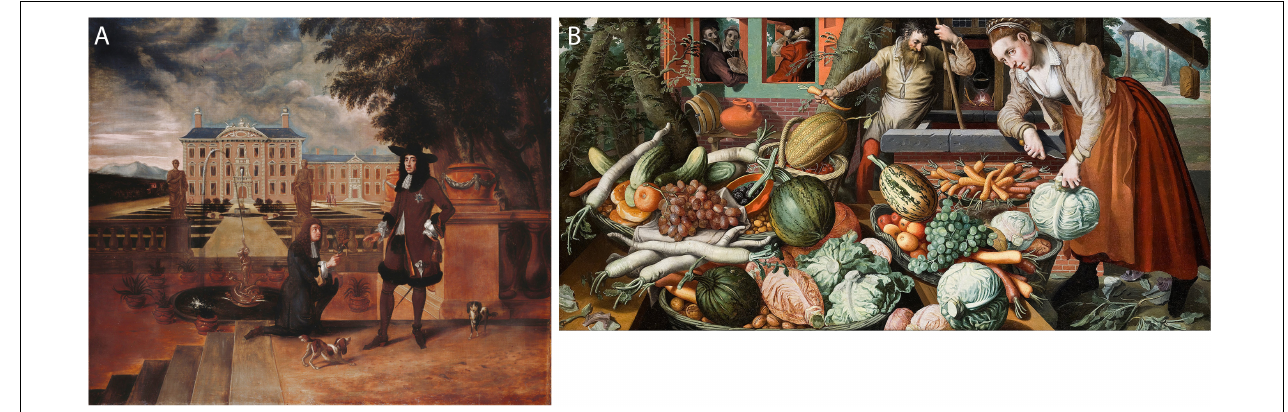
FIGURE 1 | Representative examples illustrating depicted fruits and vegetables. (A) Hendrick Danckerts, King Charles II of England, Scotland and Ireland, being given a pineapple by his royal gardener, John Rose, 1675, oil on canvas, Royal Collection. (B) Pieter Aertsen, market scene, 1569, oil on canvas, Hallwyl